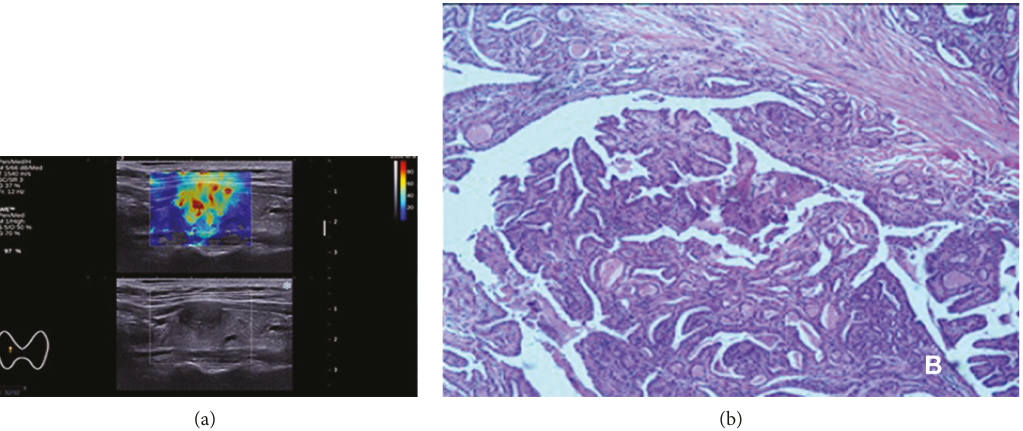
Figure 2: Thyroid papillary carcinoma in a 56-year-old woman. (a) Conventional US image represents a very hypoechoic, solid, and extrathyroidal extension. 2D-SWE mapping shows yellow and red areas indicative of a high Young ’ s modulus. (b) Histological imaging was performed for veri fi cation after surgery; HE, 40x magni fi